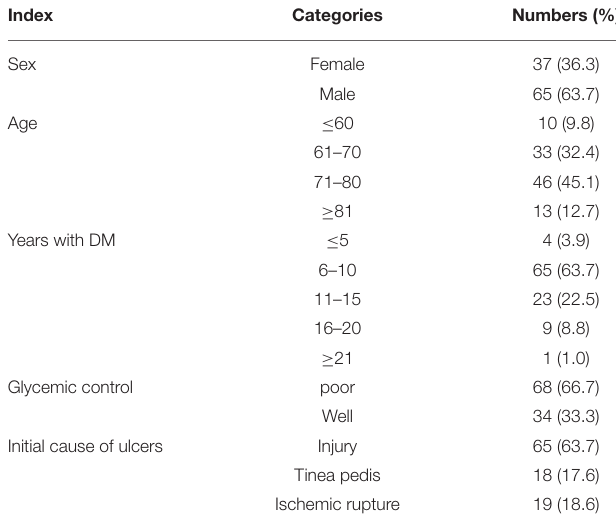
TABLE 1 | General information of the 102 DFI